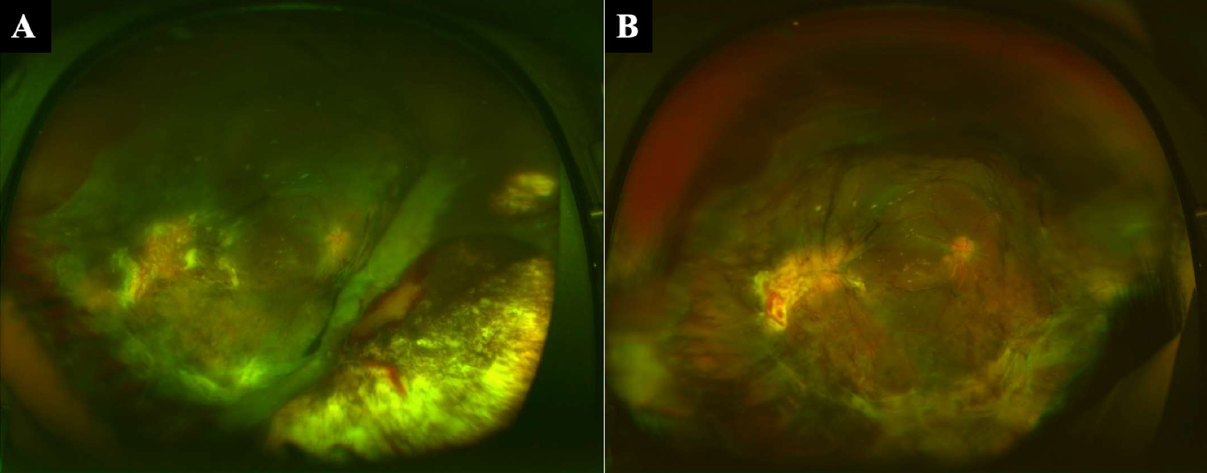
Figure 1. Fundus photographs before and after the mattress suturing technique. A 17-year-old man had choroidal avulsion after surgery for globe rupture. The retina-choroid gradually slid down together to the posterior pole, and the exposed sclera gradually widened, especially in the infero-nasal quadrant ( A ). The retina-choroid, which had been sliding down to the posterior pole, was stretched after the repair of the choroidal avulsion ( B